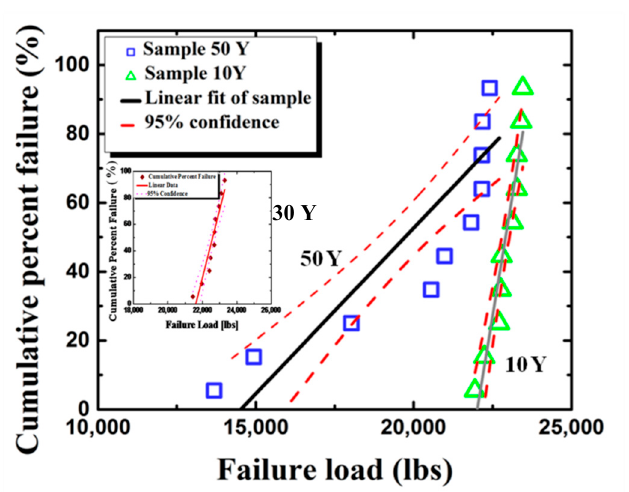
Figure 9. Cumulative probability of failure of porcelain insulator samples with ages.